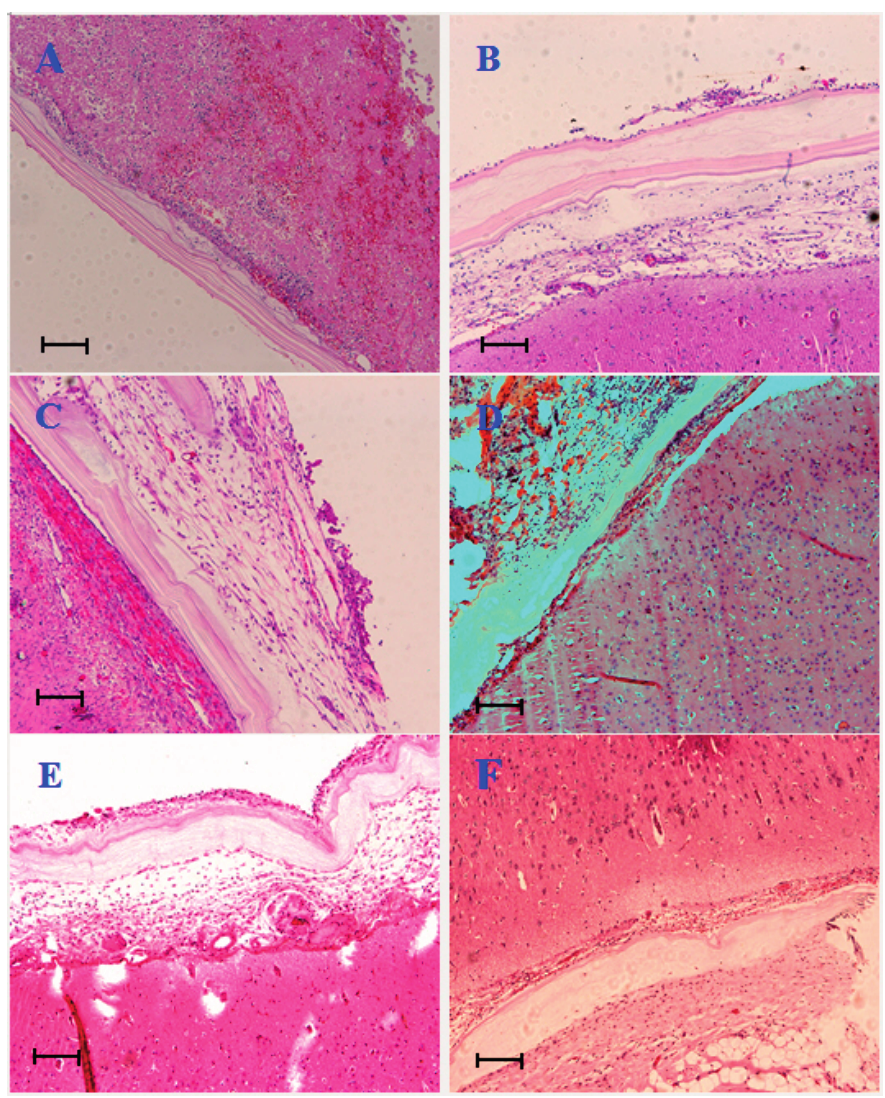
Figure 2. Histopathological observation of BC after repair surgery at each time point. (HE , hematoxylin and eosin stain ×100). ( A ) Day 7, BC membrane evenly covered the brain surface. A few inflammatory cells accumulated on the inner side of BC; ( B ) Day 14, new blood vessels emerged on the inner side of BC; ( C ) Day 30, fibroblasts grew on the inner side of BC, the cells arranged in neat rows, some collagen fibers present. No inflammatory cell infiltration; ( D , E ) Days 90 and 180, fibrous connective tissues further proliferated on the outer side of BC; and ( F ) Day 360, the structure of the BC membrane was still distinct. Scale bars = 50 µm in ( A – F